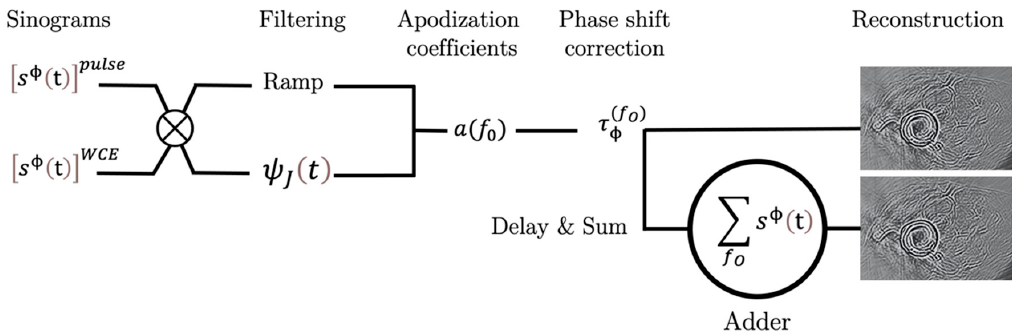
Figure 9. A flow chart of the USCT processing.